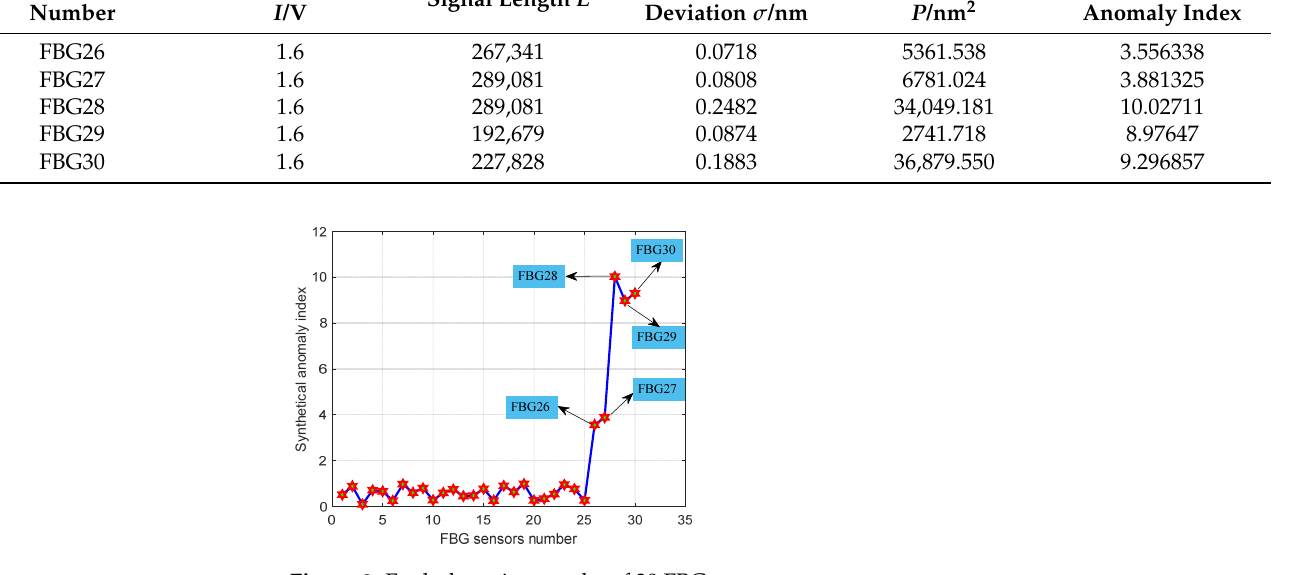
Figure 9. Fault detection results of 30 FBG sensors.